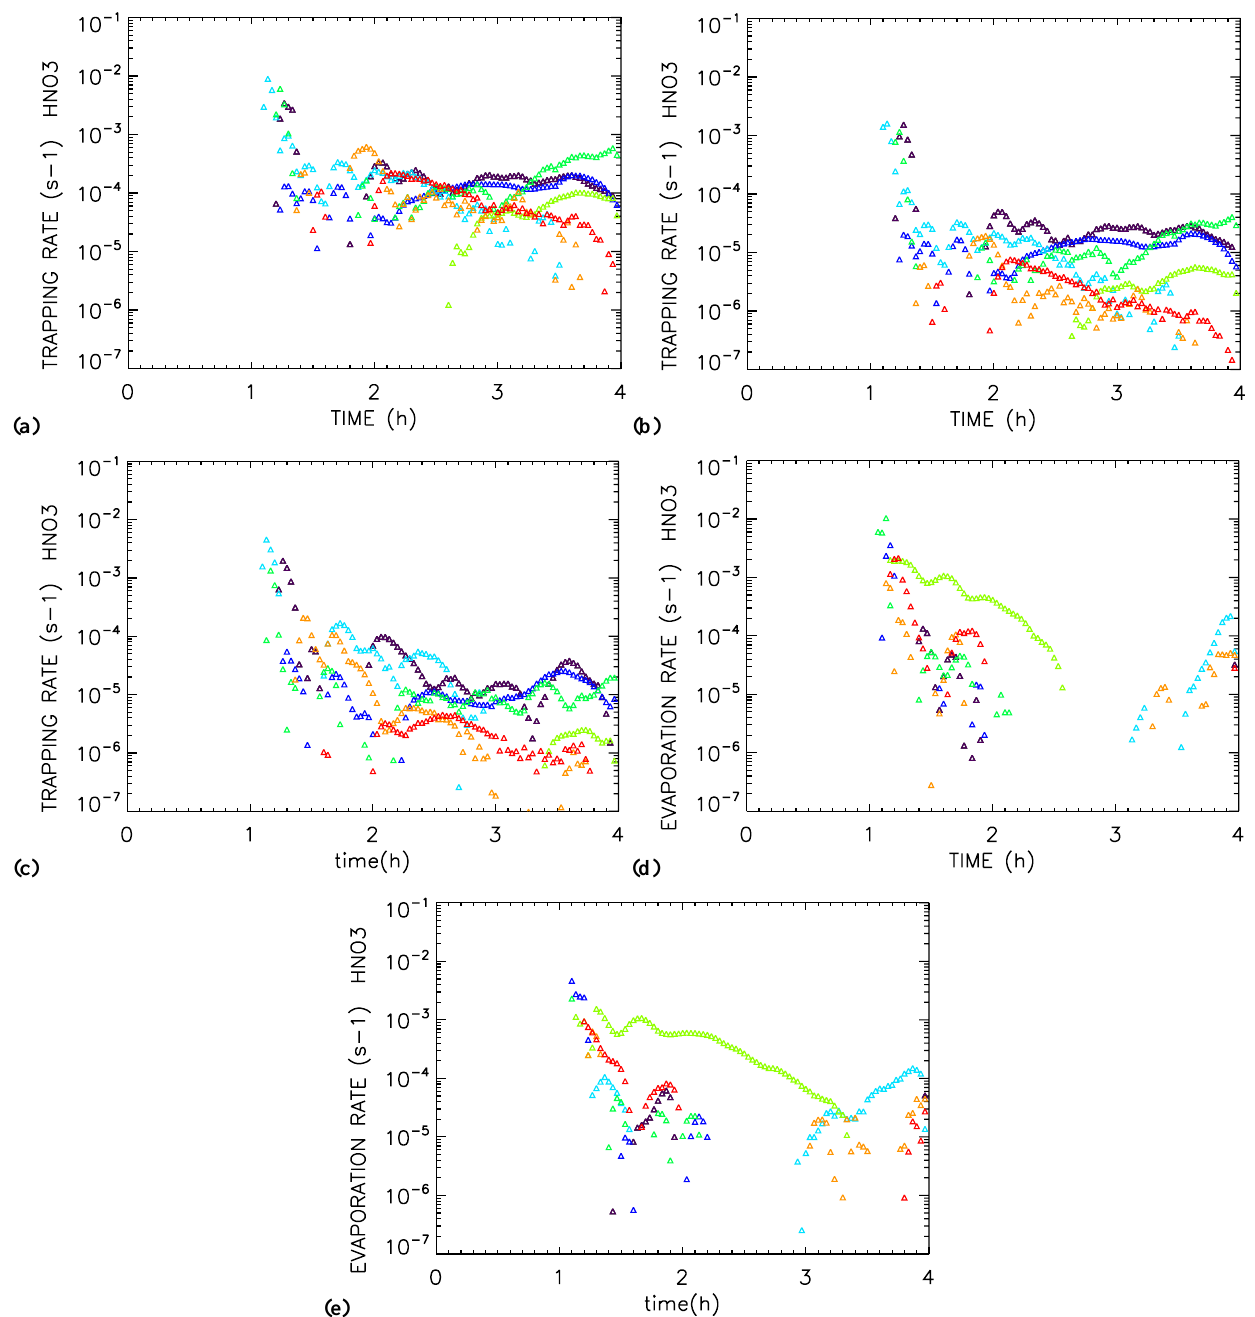
Fig. 12. Trapping and evaporation rates of HNO 3 computed in the trapping theory. (a) trapping rate computed for gas HNO 3 mixing ratios between 0 and 100 pptv, along trajectories of the REF simulation (b) trapping rates computed for gas HNO 3 mixing ratios between 5 and 10 ppbv, along trajectories of the REF simulation (c) same as (b) along trajectories of the RUN1M simulation, (d) evaporation rate computed along trajectories of the REF simulation, (e) same as (d) for the RUN1M